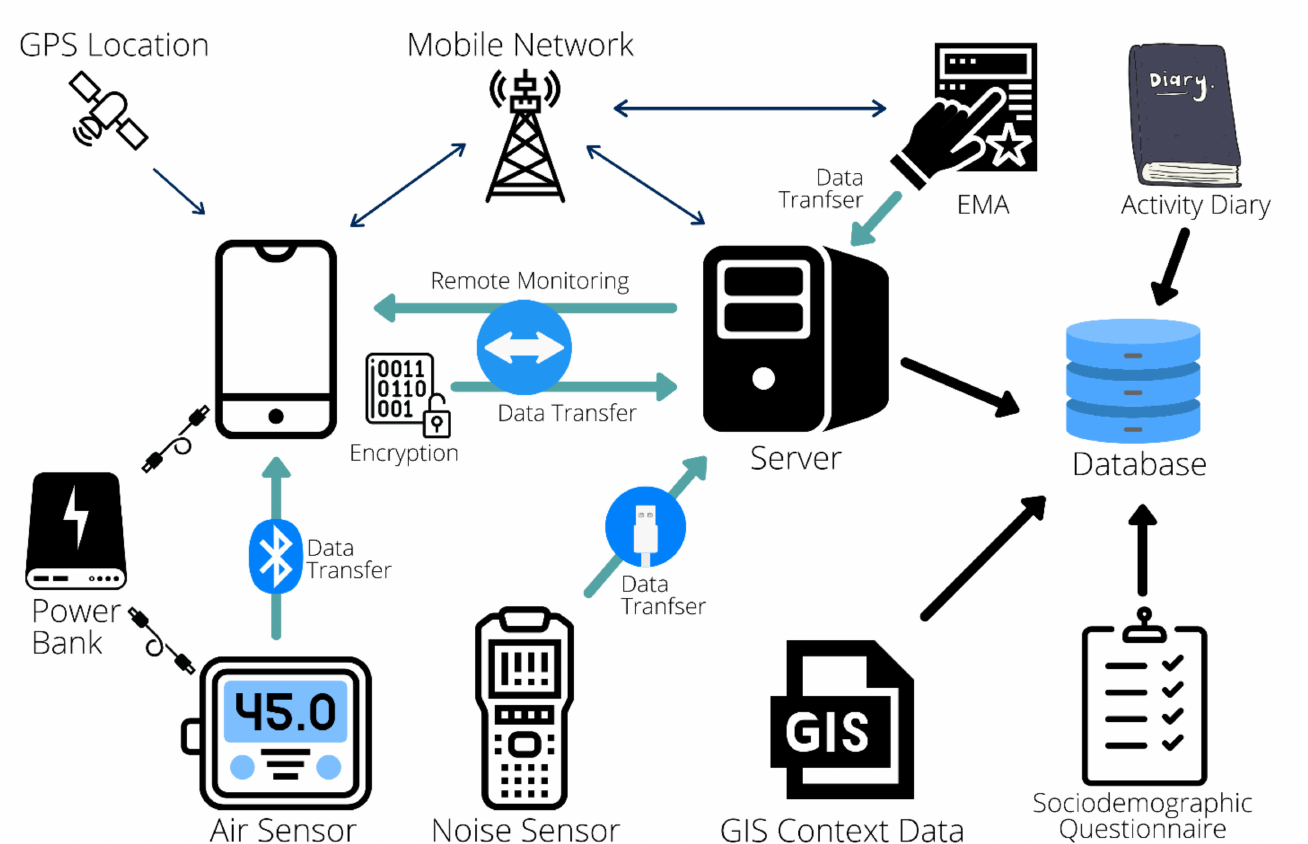
Figure 1. The system overview of the individual environmental exposure assessment